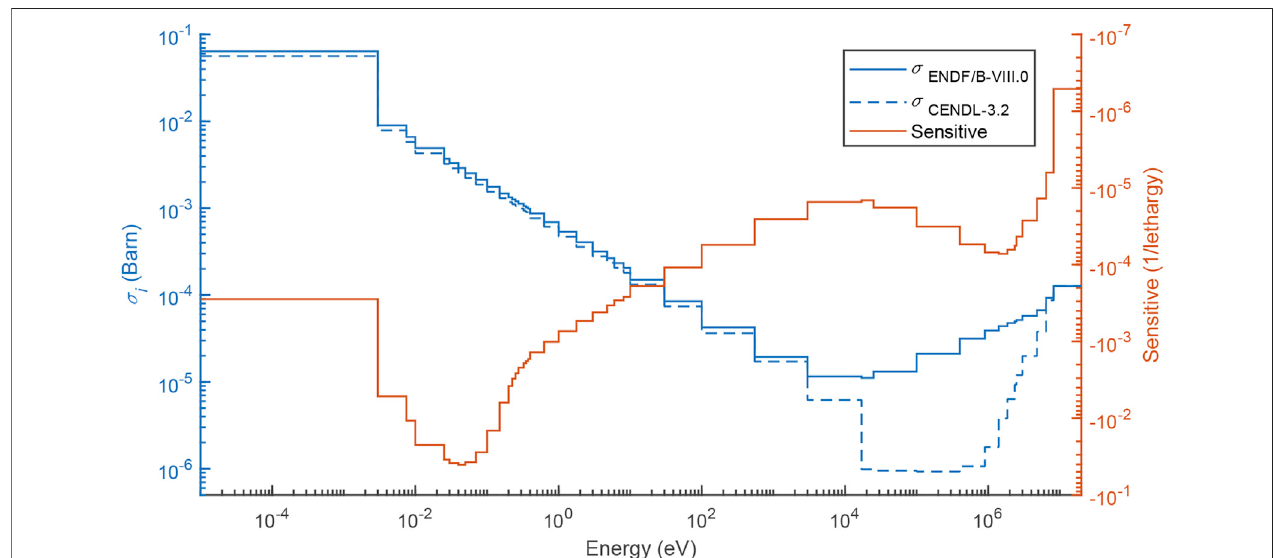
FIGURE 6 | Sensitivity and multi-group cross-sections of C-12 (n, γ ) channel.